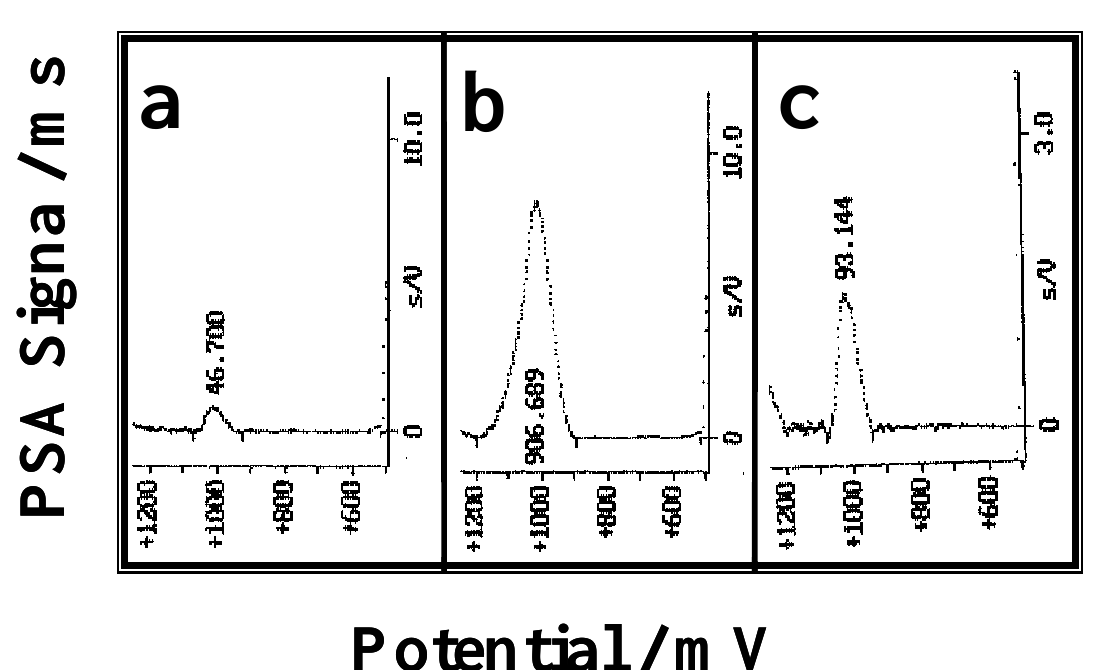
Figure 1. Chronopotentiograms obtained in a 0.200 M acetate buffer solution pH 5.00 for 0.5 ppm oligo(dG) after 30 sec (a) and 3 min (b) accumulation, and for 1.0 ppm dsDNA after 15 min accumulation (c) at 0.200 V. Stripping conditions: initial potential: 0.500 V; current: 8.0